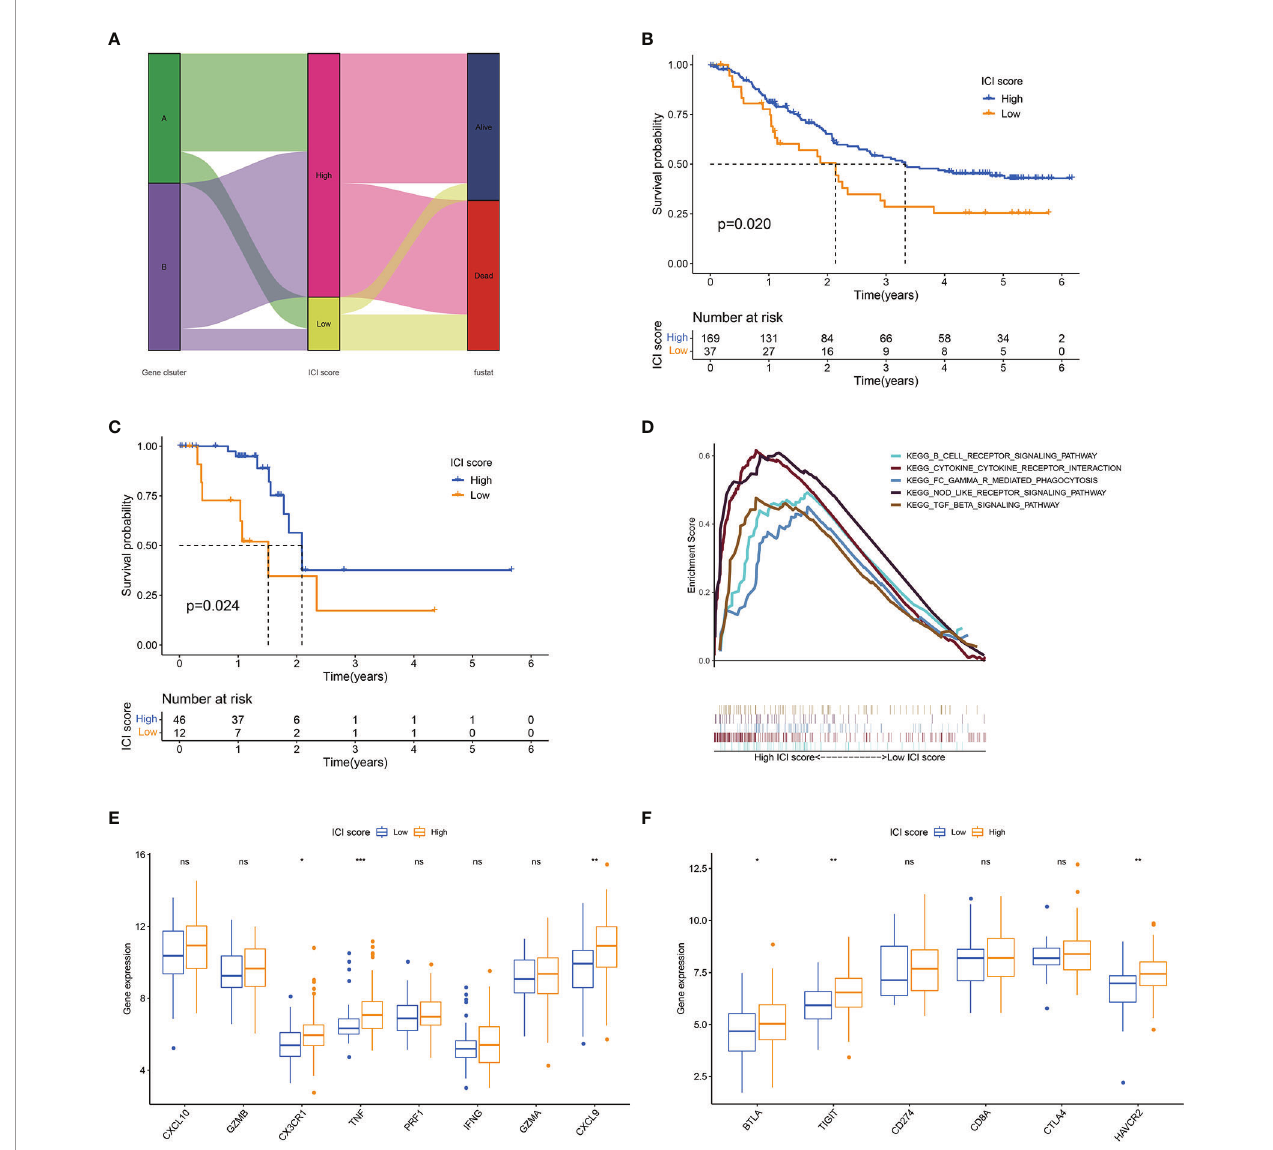
FIGURE 3 | ICI score analysis. (A) Alluvial diagram of gene cluster distribution and survival outcome between high and low ICI score groups. (B) Kaplan – Meier curves for high and low ICI score groups in all samples. Log rank test P = 0.020. (C) Kaplan – Meier curves for high and low ICI score groups in the TCGA cohort. Log rank test P = 0.024. (D) GSEA of high and low ICI score groups. (E) Box plot of the expression levels of immune activity-related signature genes ( CXCL10 , GZMB , CX3CR1 , TNF , PRF1 , IFNG , GZMA and CXCL9 ) between high and low ICI score groups. (F) Box plot of the expression levels of immune checkpoint signature genes ( BTLA , TIGIT , CD274 , CD8A , CTLA4 and HAVCR2 ) between high and low ICI score groups. * P < 0.05; ** P < 0.01; *** P < 0.001; ns, no signi fi